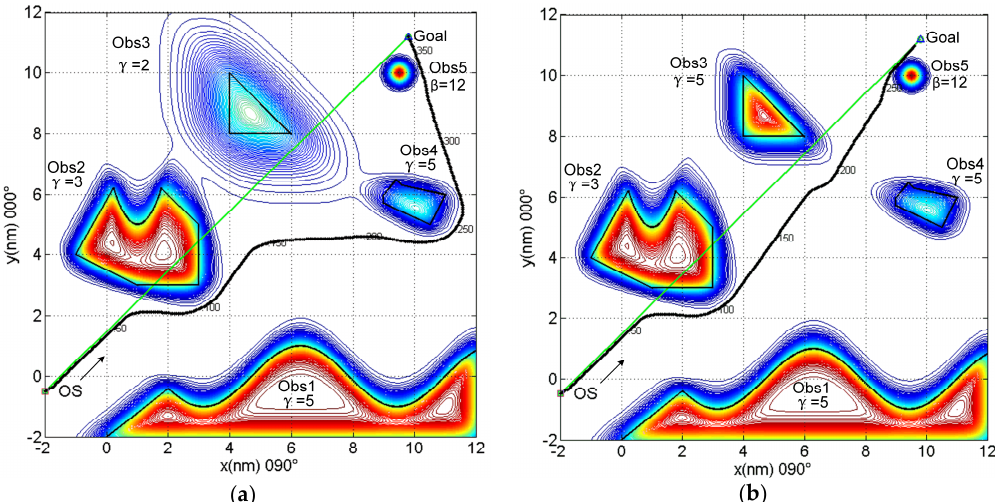
Figure 11. The static obstacle is a U-shaped slot, a composite potential field composed of a parabola